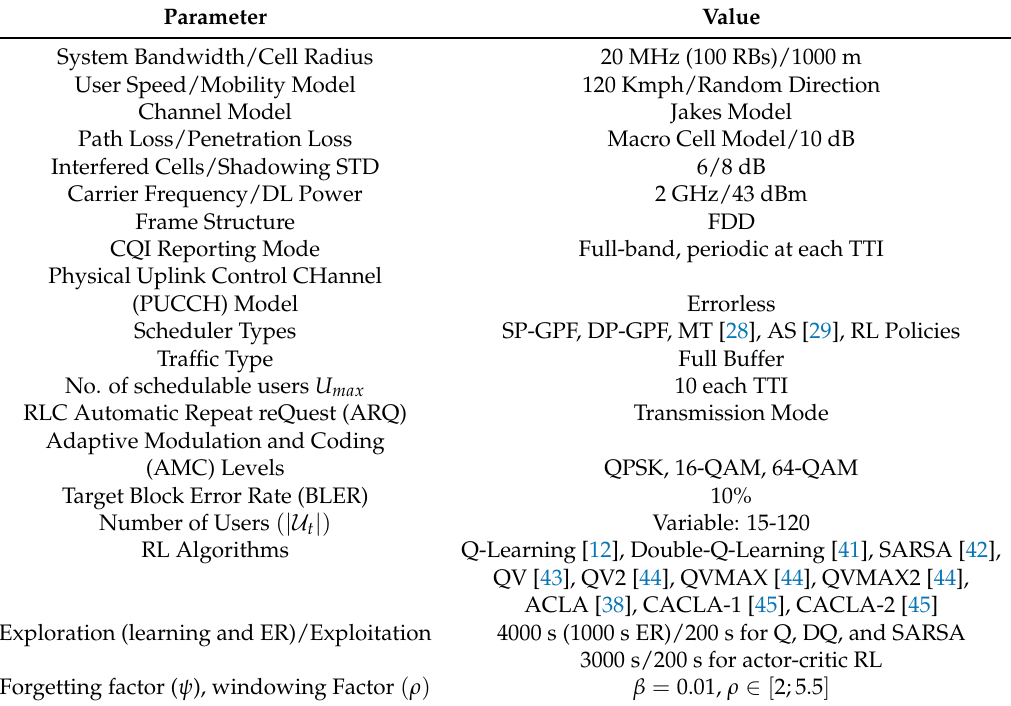
Table 1. Simulation settings .